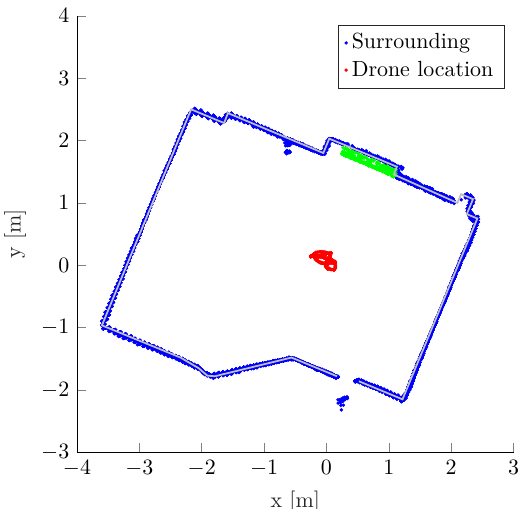
Figure 5. The map was generated during a three-minute flight inside a room of the institute. The points around (0.3, 2.2) are the pilot standing behind a protective cardboard with a lookhole. On − the wall opposite of the pilot, a double-line is visible because there is a heater near the ground (green) which is not visible at higher altitudes. This is an example of a static environment that becomes dynamic due to the 2D mapping. The ground-truth is shown in gray.